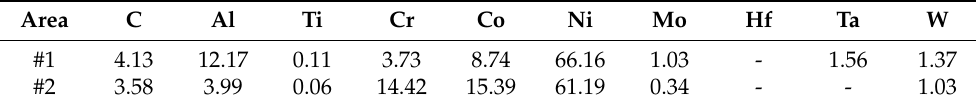
Figure 4. TEM images of TLP-diffusion-bonded joint: ( a – d , f , g ) bright-field TEM image and ( e ) selected area diffraction indexed from ( a ). Table 3. TEM-EDS scan results according to Figure 4 (at.%).